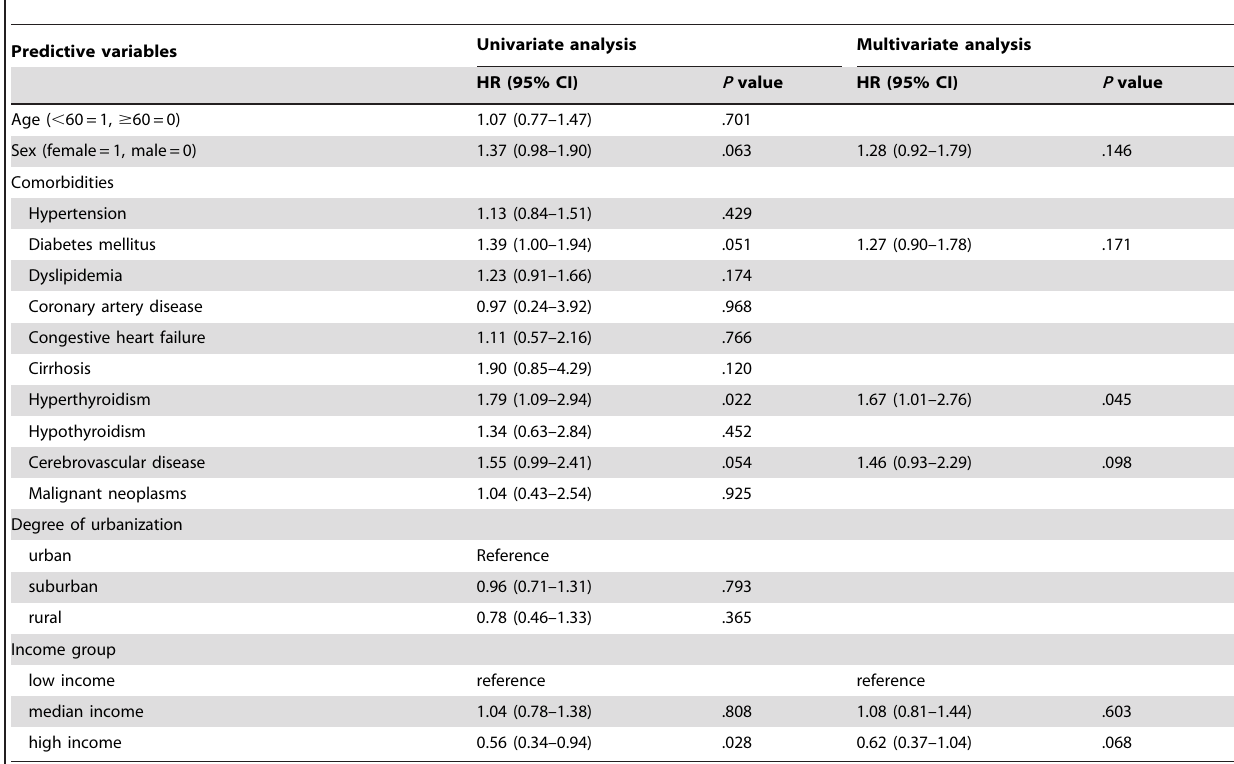
Table 4. Analyses of Risk factors for Depressive Disorders in Rheumatoid Arthritis